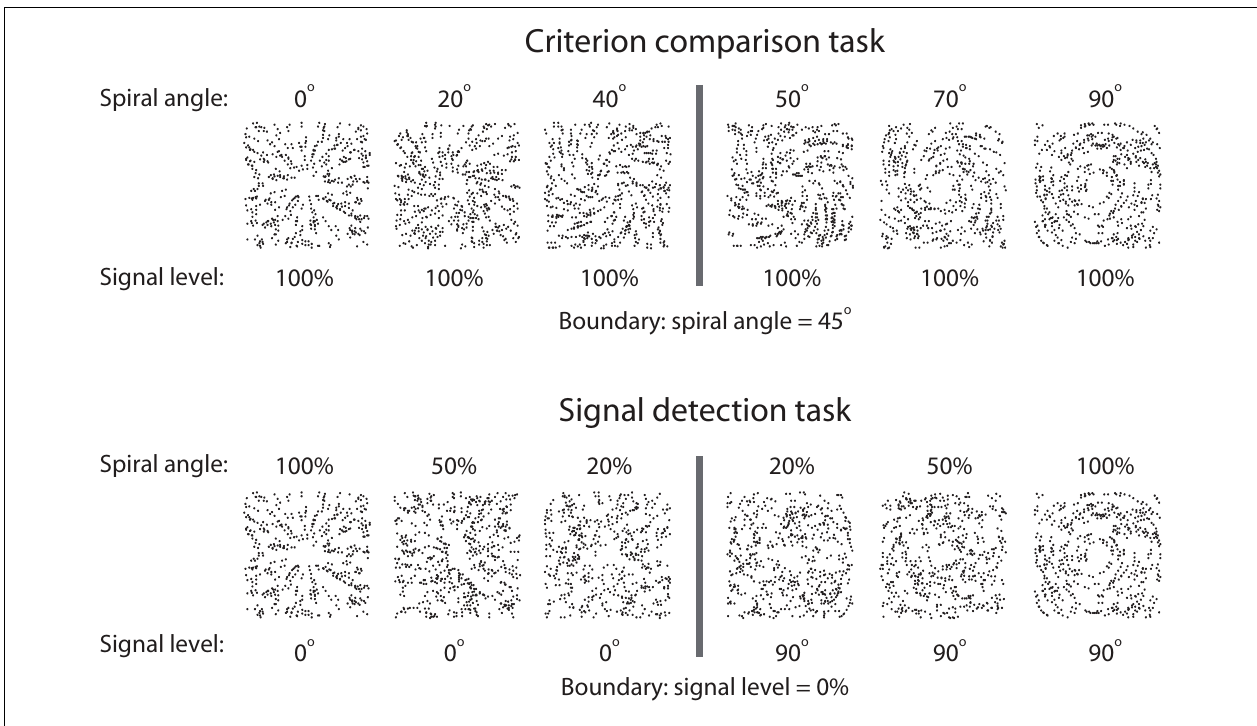
90 ◦ . For the signal detection task, Glass patterns of 0 ◦ (radial) and 90 ◦ (concentric) spiral angles were presented, and the signal level varied between 0 and 100%. Modified from Li and Yang